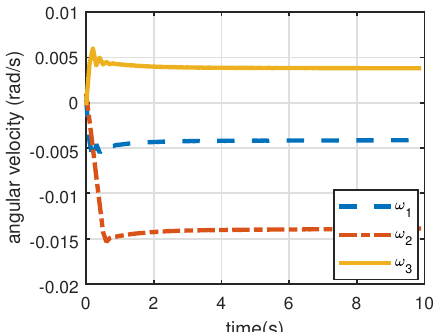
Figure 10. The evolution of angular velocities.